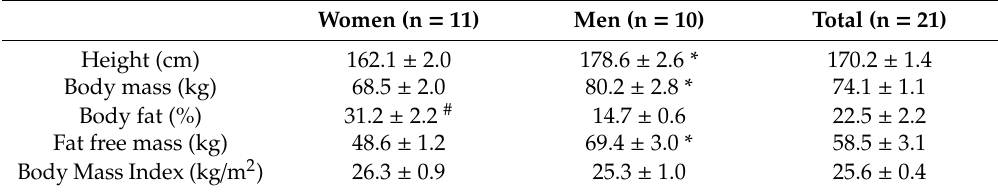
Table 1. Physical characteristics (mean ± sem) of our participants.